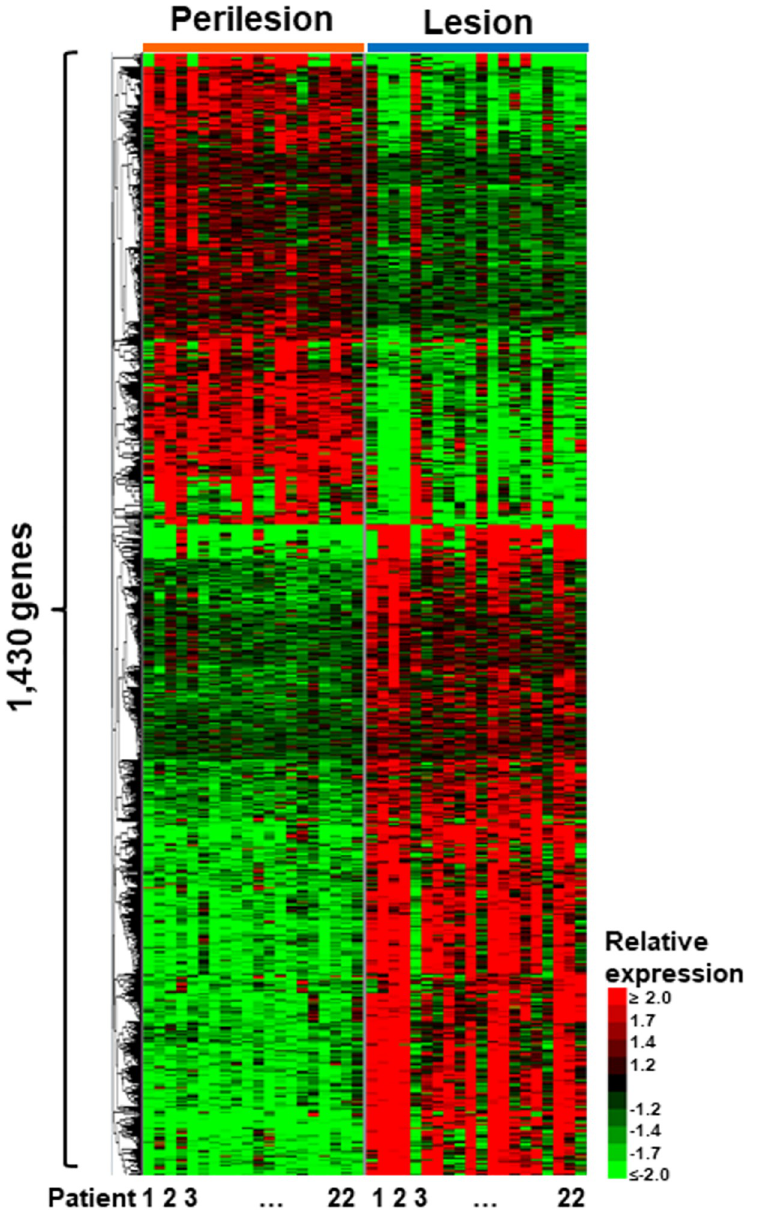
Fig 1. Overview of the current dataset, differential expression analysis, and comparison to microarray-based study. 1,430 protein coding genes were identified as being differentially expressed when comparing lesion and non- lesion samples. The heatmap shows the gene expression patterns (rows) for each individual patient sample (columns).